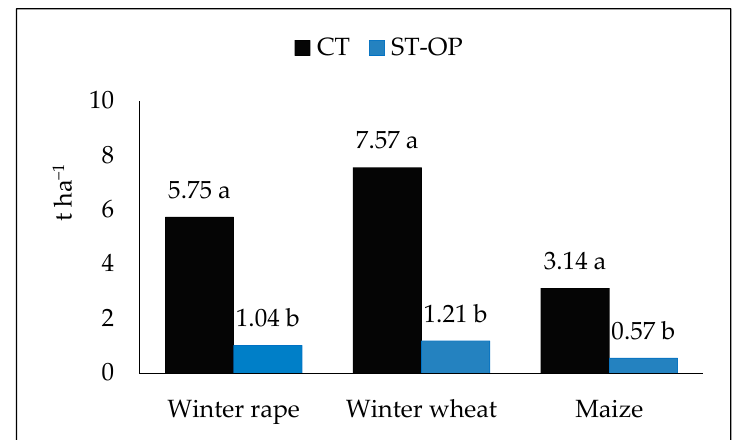
Figure 4. Soil loss during the growing season of winter rape (2015/2016), winter wheat (2016/2017), and maize (2018) depending on the method of soil tillage. Conventional (CT) and strip-till one-pass (ST-OP). The letters a and b indicate significant difference for tillage methods at p < 0.05.